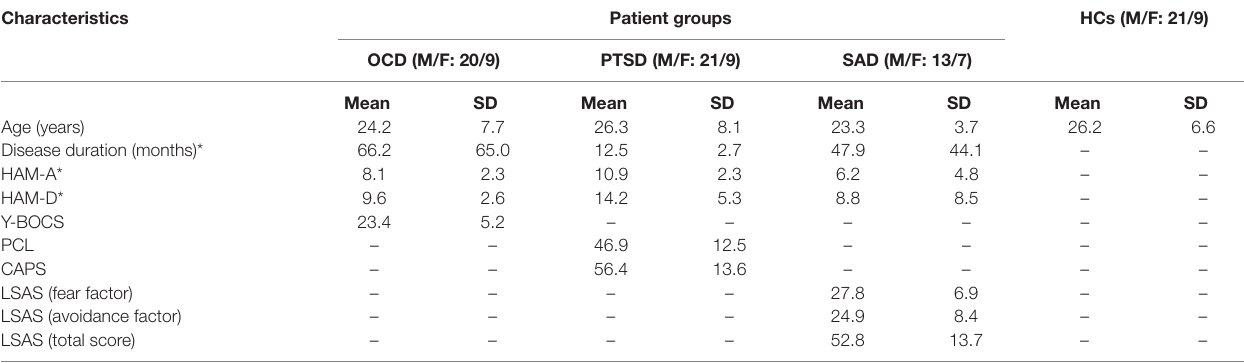
TaBle 1 | Demographic data and clinical characteristics.